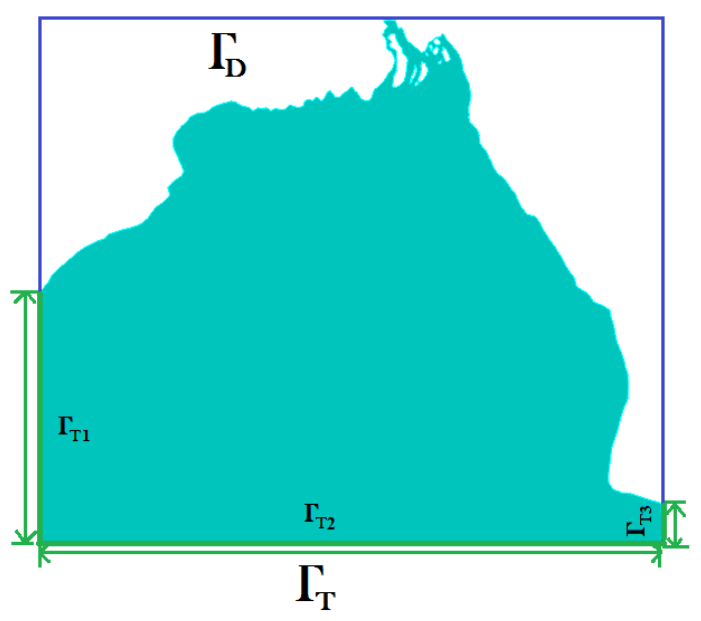
Figure 7. The domain for the Bay of Bengal region with the information of boundaries, Γ D and Γ T (= Γ T1 ∪ Γ T2 ∪ Γ T3 ) used in Example